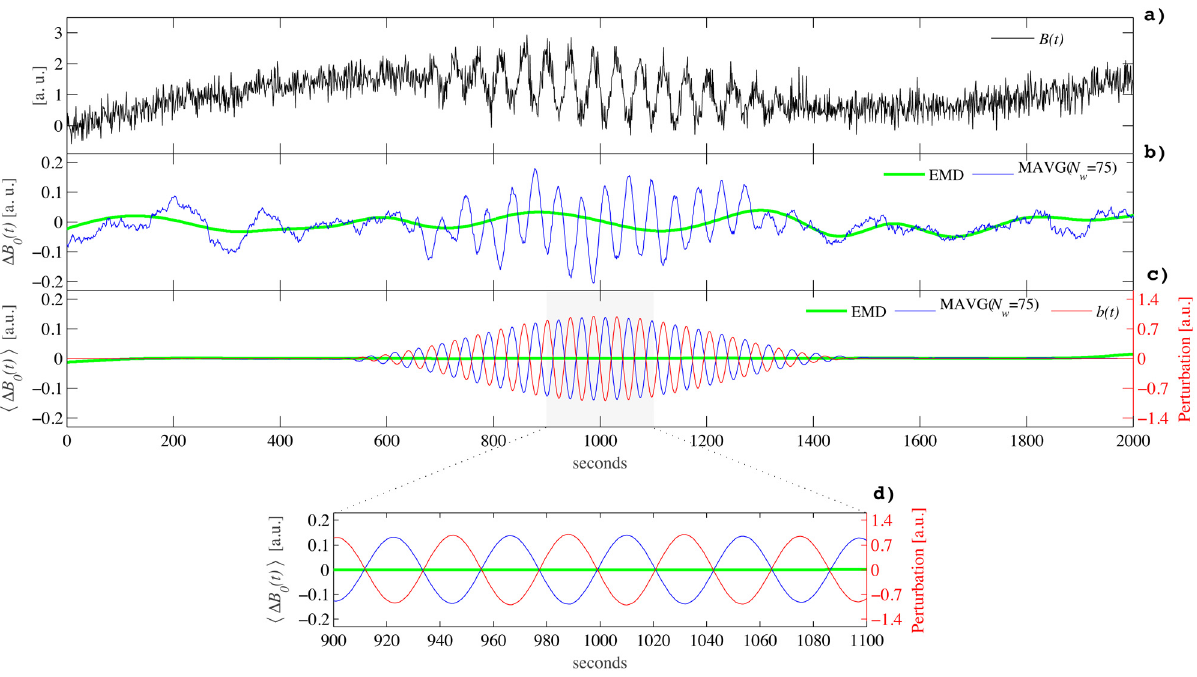
( t ) between the original B ( t ) and that 0 0